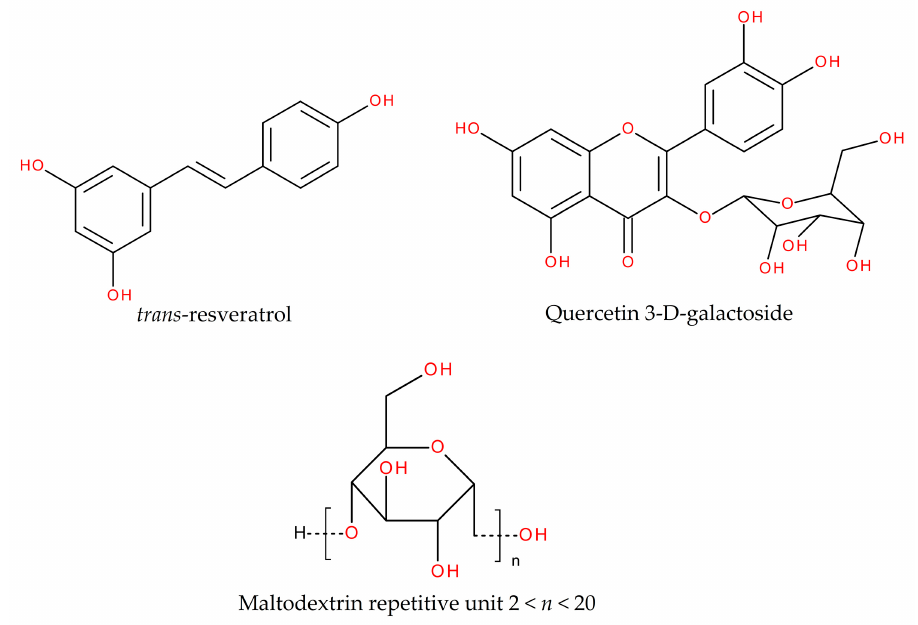
Figure 2. Schematic representation of chemical structures of resveratrol, quercetin 3-D-galactoside and the maltodextrin repetitive unit.